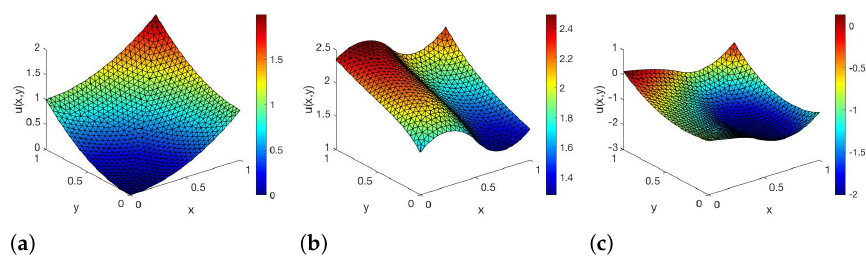
Figure 1. FE solutions of (25) for parameters ( a ) µ = ( 0,0 ) , ( b ) µ = ( 0,1 ) and ( c ) µ = ( 1,0 )